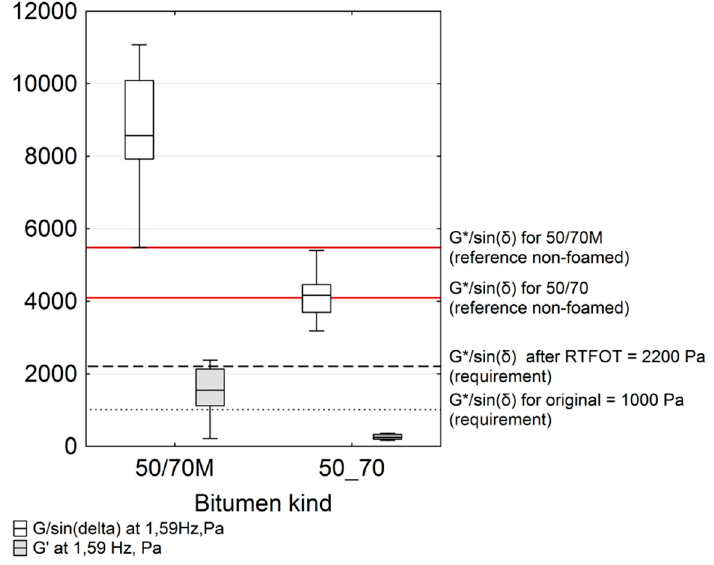
Figure 6. Box plot for G*/sin( δ ) and the elastic component of the complex modulus at frequency 1.59 Hz at 60 °C.